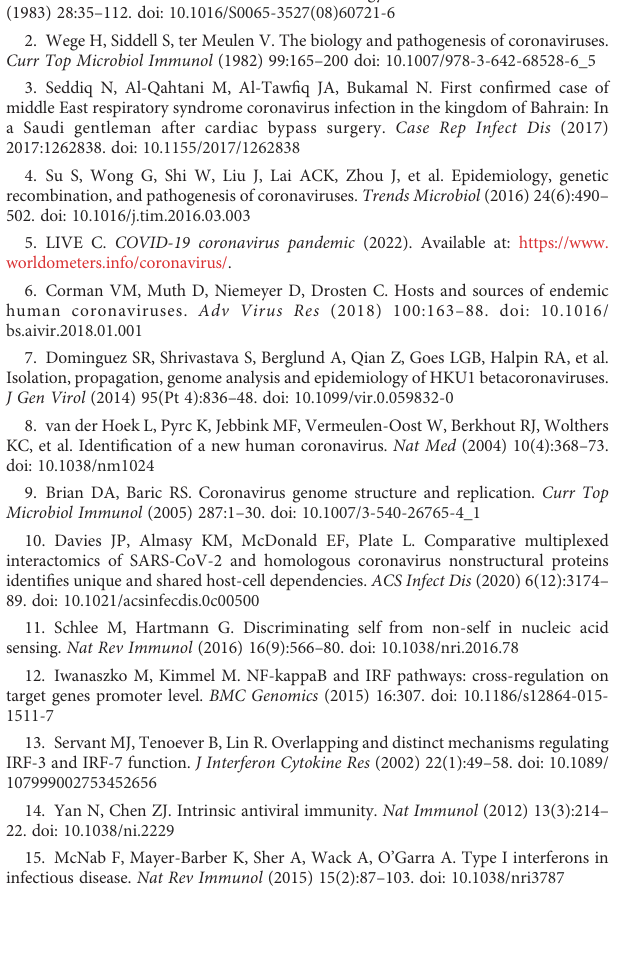
SUPPLEMENTARY FIGURE 4 Human dermal fi broblasts were left uninfected (-) or infected (+) with 229E (A) or OC43 (B) at MOI of 0.01. The activation of IRF1, IRF3 and IRF7 was determined by western blot analysis using antibodies against 229E N protein, OC43 N protein, IRF1, IRF3, IRF7, phosphorylated (p-IRF3) and GAPDH. SUPPLEMENTARY FIGURE 5 H1299 cells were transfected with control pcDNA3 plasmid (Cont) or the plasmid containing IRF1, IRF3 or IRF7. At 24 hours after transfection, the expression of GBP2, IFI2, MAP2, RIG-I, STAT2 and IFN- b was determined by RT-qPCR (n=4). *p<0.05, **p<0.01, ***p<0.001, ****p<0.0001, Two- way ANOVA.